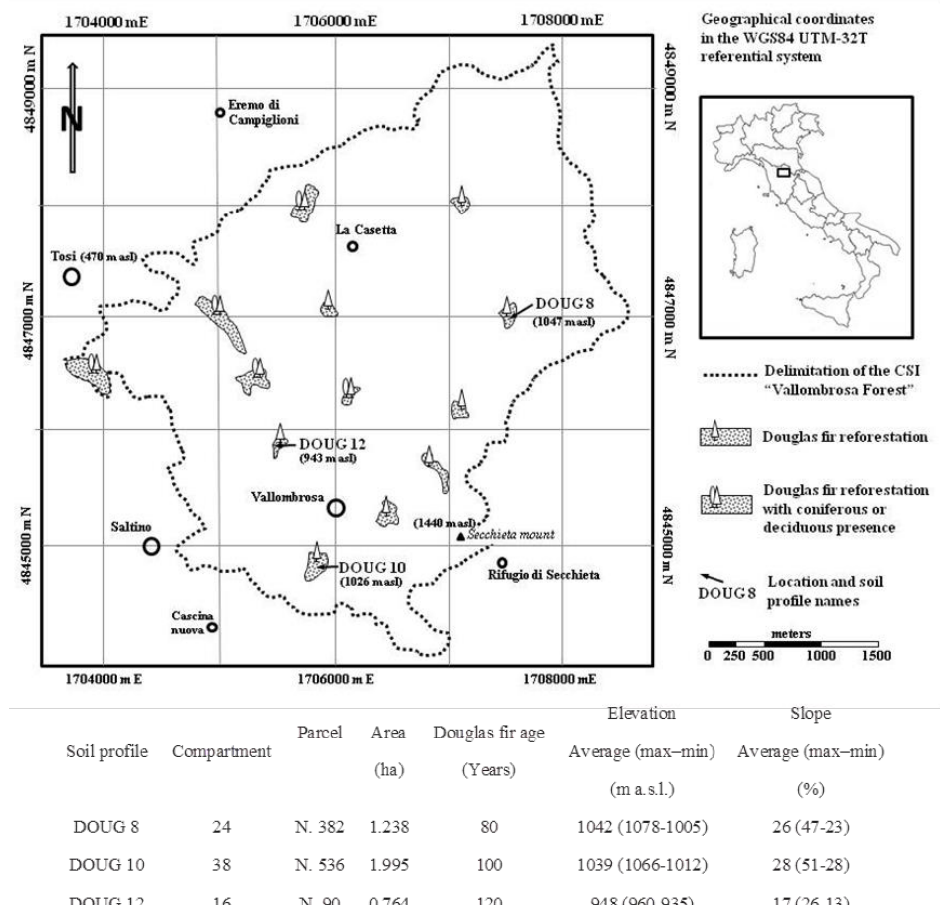
Figure 1. Location of soil survey. DOUG8, DOUG10 and DOUG12 are soil profiles opened in the three Douglas fir stand age areas. In table are shown the surface extension, the elevation and the slope of the forest